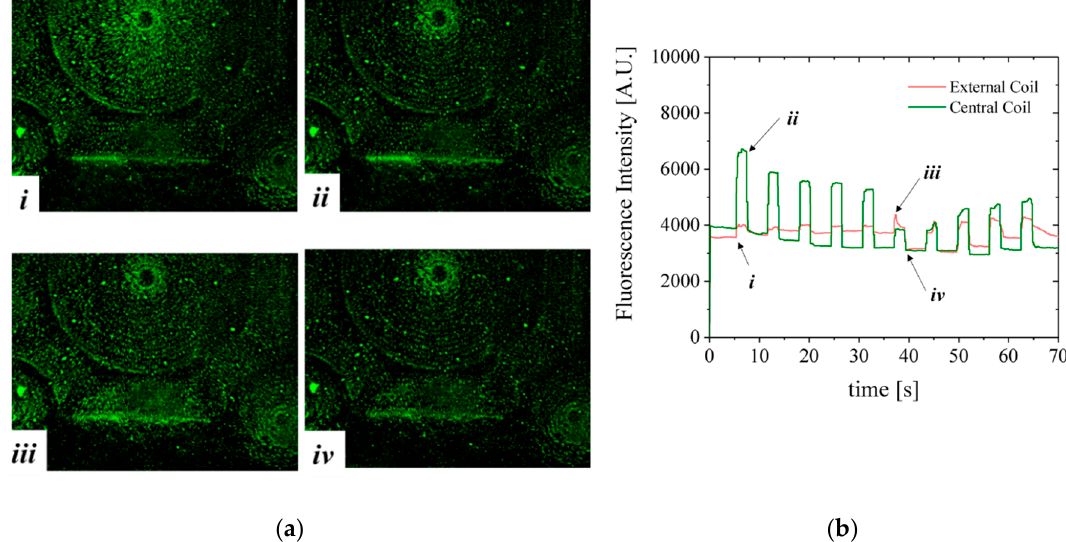
Figure 10. ( a ) Visualization of MB trapping and repulsion while actuating the CRIN MEMT design with 5 pulses of 2 s duration and 4 s interval with current +1 A followed by 5 pulses with current − 1 A. (i) Start of +1 A pulse for 2 s duration. Synchronous attraction to the central coil and repulsion from the external coils is occurring; (ii) pulse stop with deactivation of current to 0 A. The fluorescence intensity of the central coil decreases abruptly; (iii) inversion of current to − 1 A. The electromagnetic force generated is directing MB away from the central coil and attracting MB to the external coils; (iv) deactivation at 0 A; ( b ) MB fluorescence signal on top of one external coil and of the central coil deriving from MB actuation. MB are in direct contact with the MEMT. (Multimedia view).